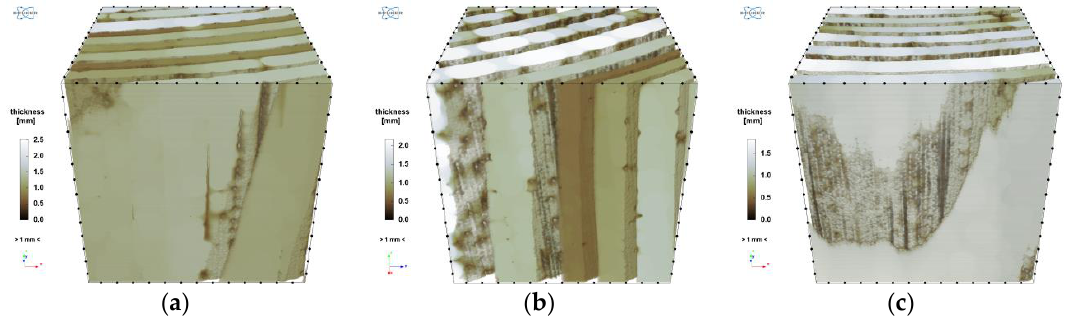
Figure 19. Distribution of local thickness of early growth rings: ( a ) sample “1” ; ( b ) sample “2” ; ( c ) sample “3”.